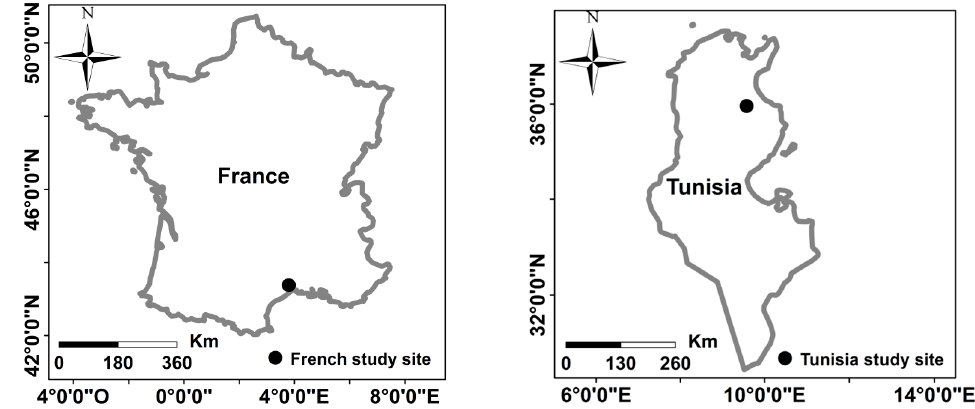
Figure 1. Location of our two study sites.